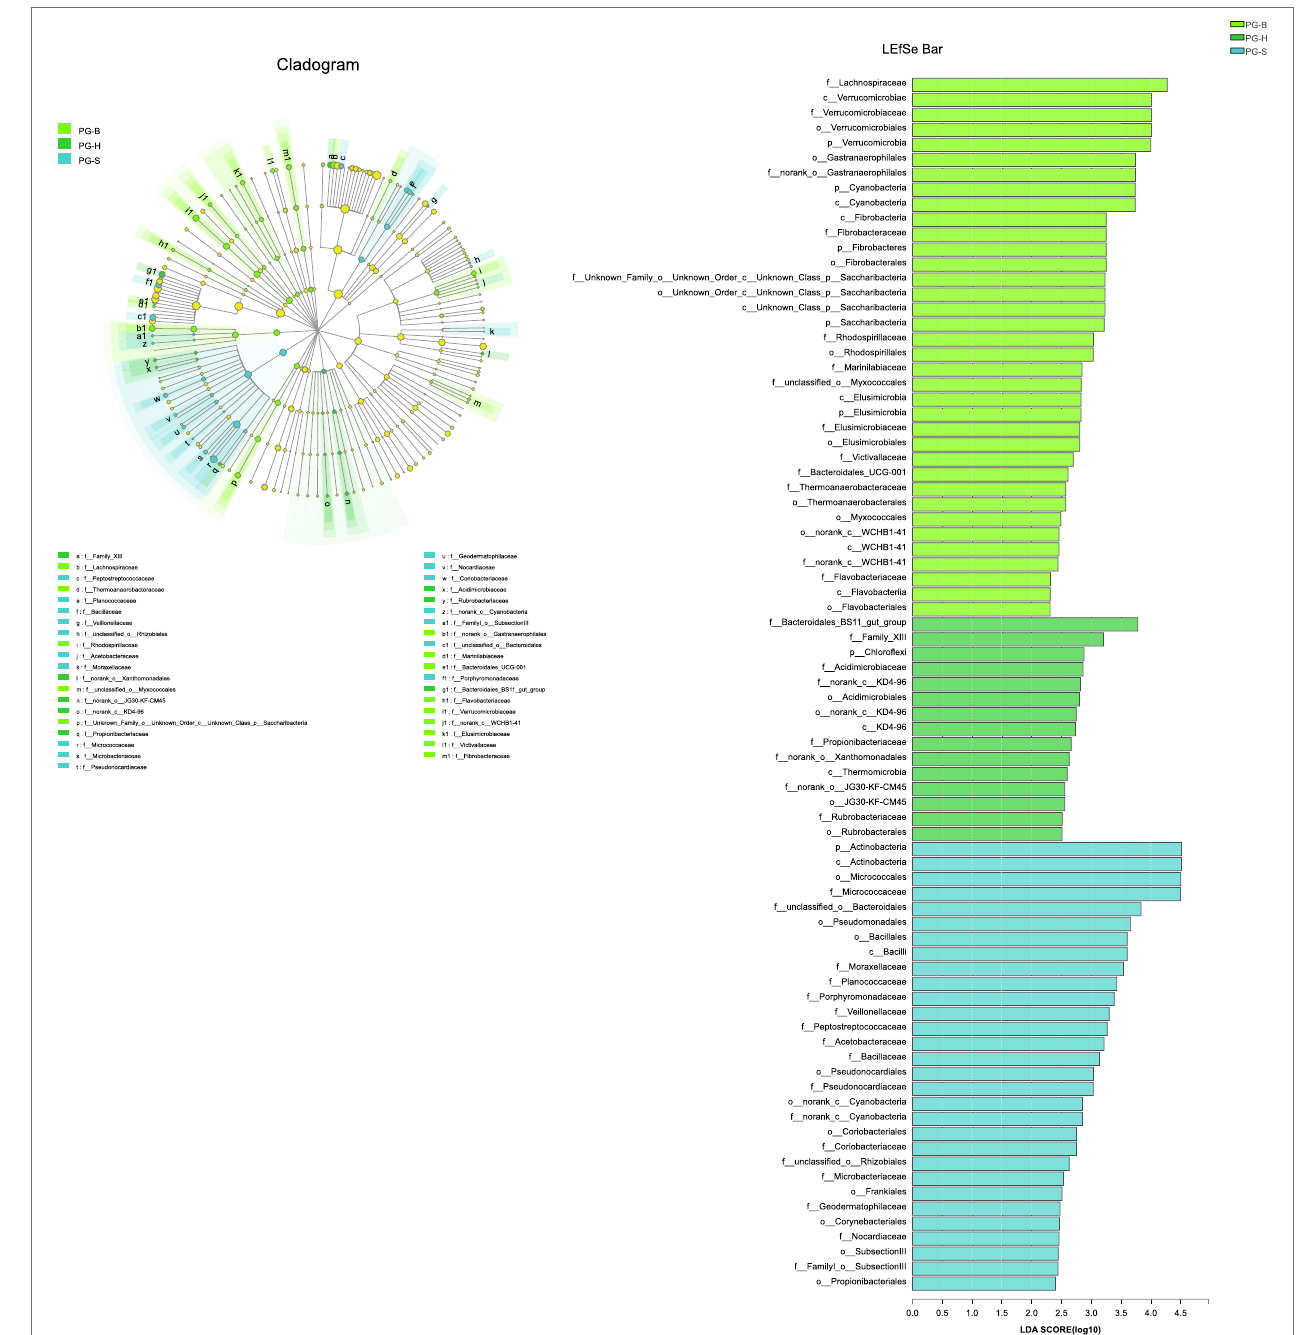
FIGURE 6 | The phyla to families that contribute to the differences between Przewalski’s gazelle populations identified by linear discriminant analysis coupled with effect size (LEfSe). PG-B (lime) is short for Przewalski’s gazelle from Bird Island, PG-H (green) is short for Przewalski’s gazelle from Haergai River and PG-S (mint) is short for Przewalski’s gazelle from Shengge